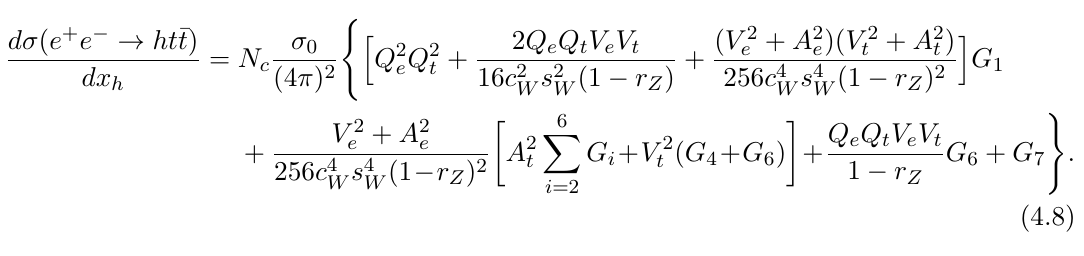
Figure 12 . Cross section for e + e and 1000 GeV (right). The horizontal line indicates the SM